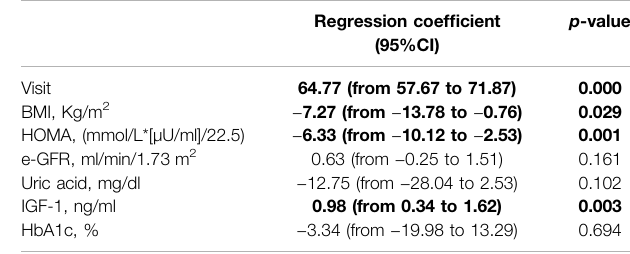
TABLE 5 | Multivariate linear mixed models of LVESV/BSA over time.